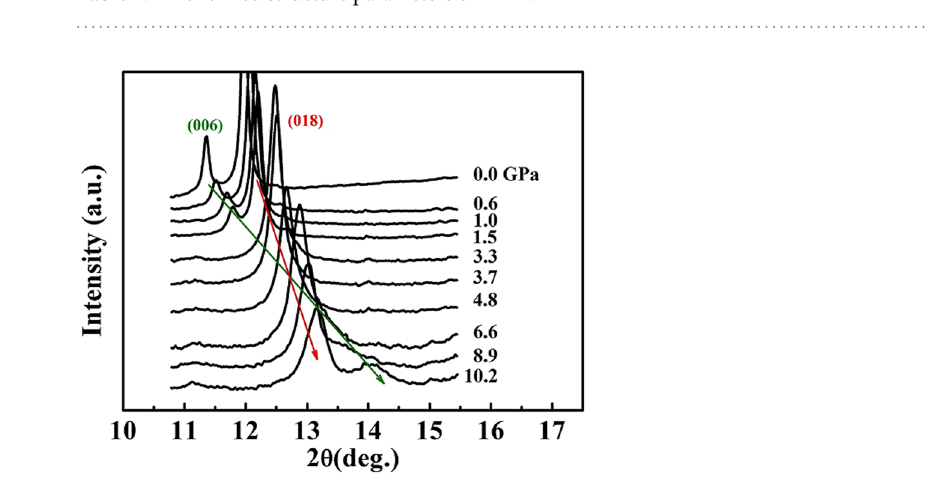
Figure 2. The pressure-dependent XRD patterns show the dramatic changes of the (006) reflection (green arrow) with pressure, in contrast with the (018) reflection (red arrow) in the 2 θ range from 10° to 16° for hydro- KBBF.